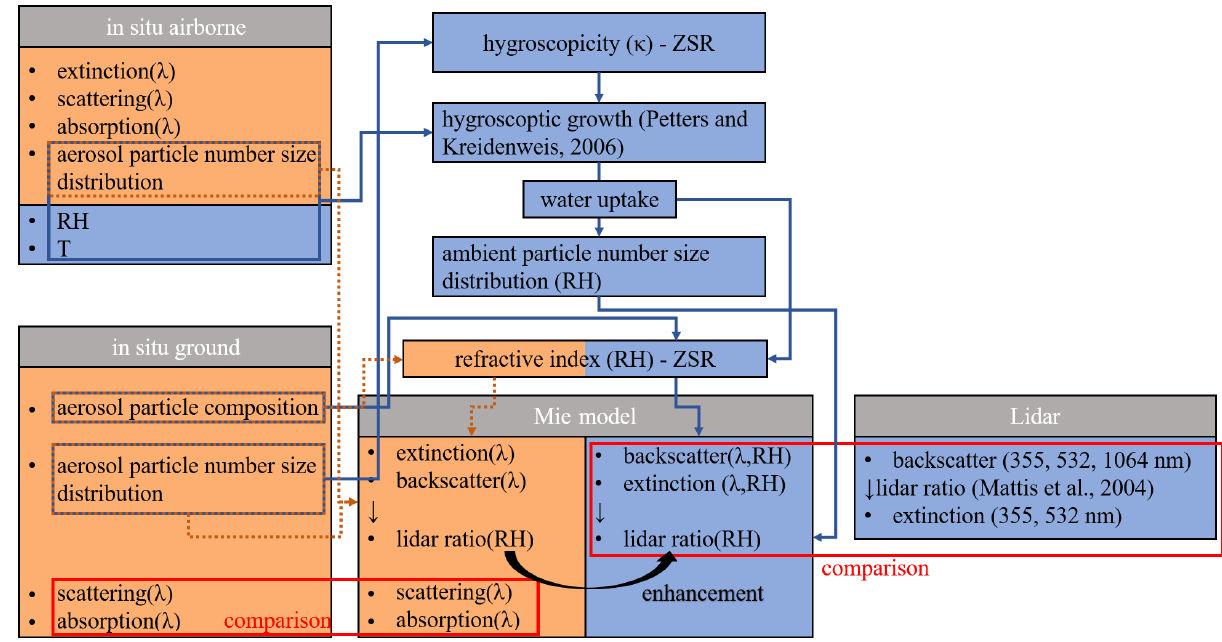
Figure 1. Flowchart of the methodology. Orange shaded areas represent the comparison in the dried aerosol state; blue shaded areas represent the pathway for the ambient